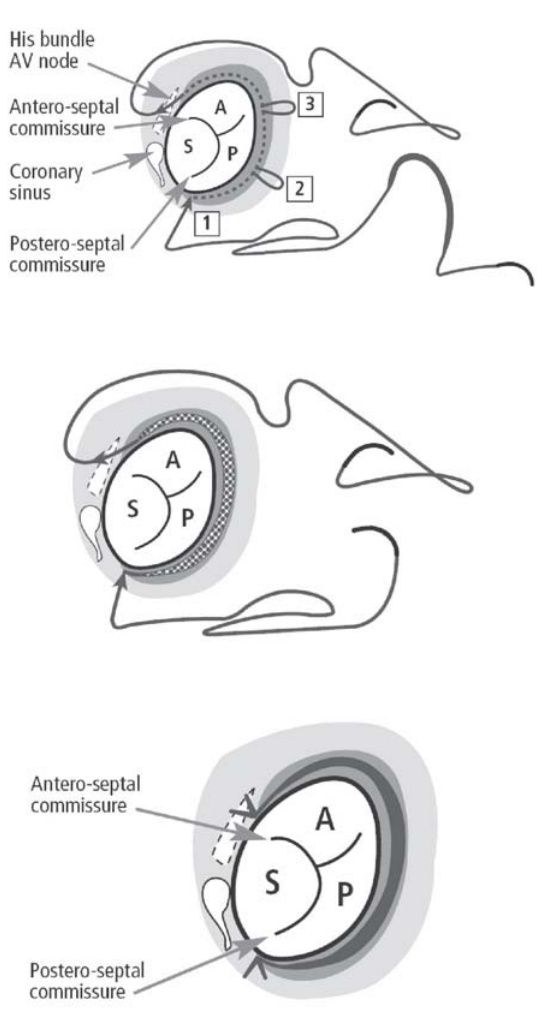
Fig. 4 - Surgical technique for tricuspid annuloplasty with sub- endocardial insertion of a tricuspid biodegradable ring